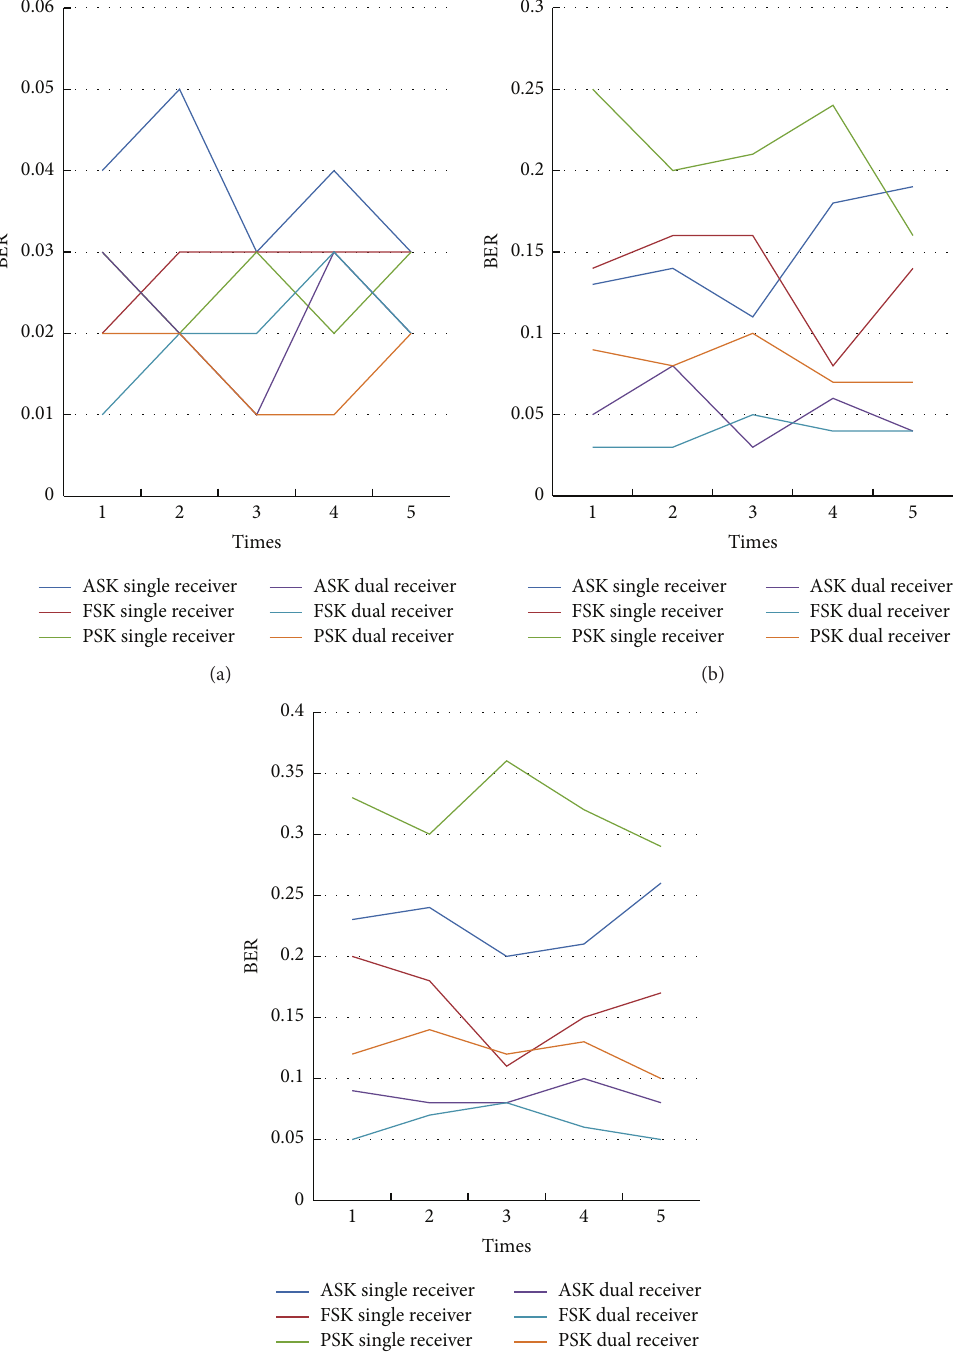
Figure 12: The measured BER curves of ASK-, FSK-, and PSK-modulated acoustic data at different rotation speeds. (a) 0, (b) 80 r/min, and (c)